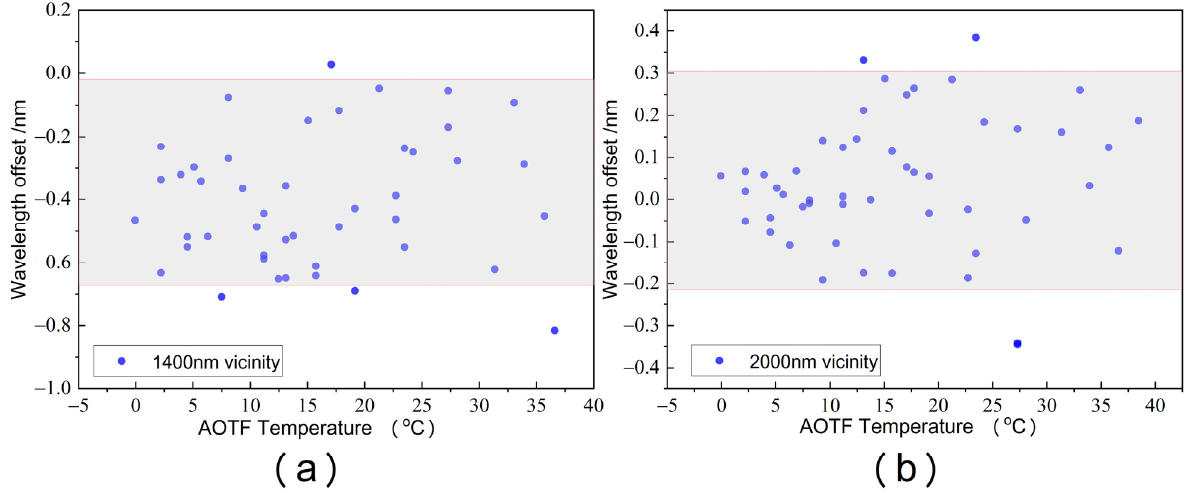
Figure 7. Calculation of wavelength migration based on the method for the corrected spectra. ( a ) Correction coefficients in the central wavelength absorption spectrum of around 1400 for CO 2 . ( b ) Correction coefficients in the central wavelength absorption spectrum of around 2000 for CO 2 . The gray boxes in the figure are the 95th percentile areas.